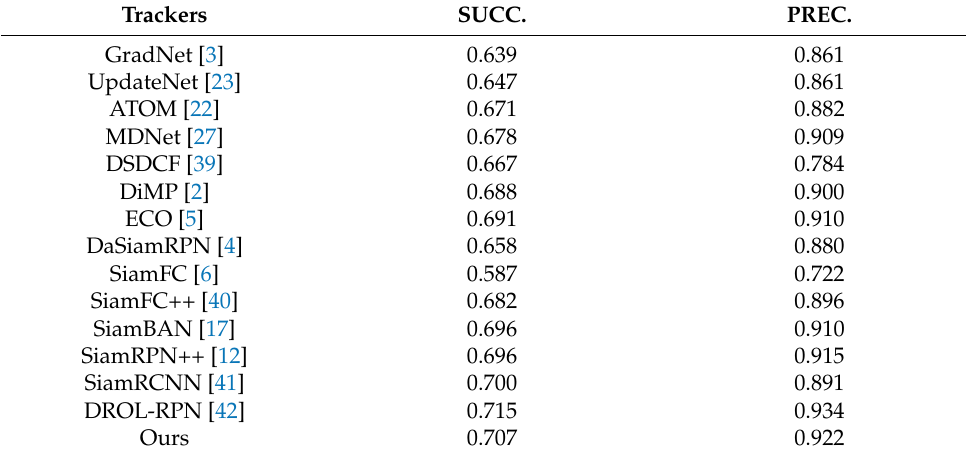
Table 2. Comparative results on